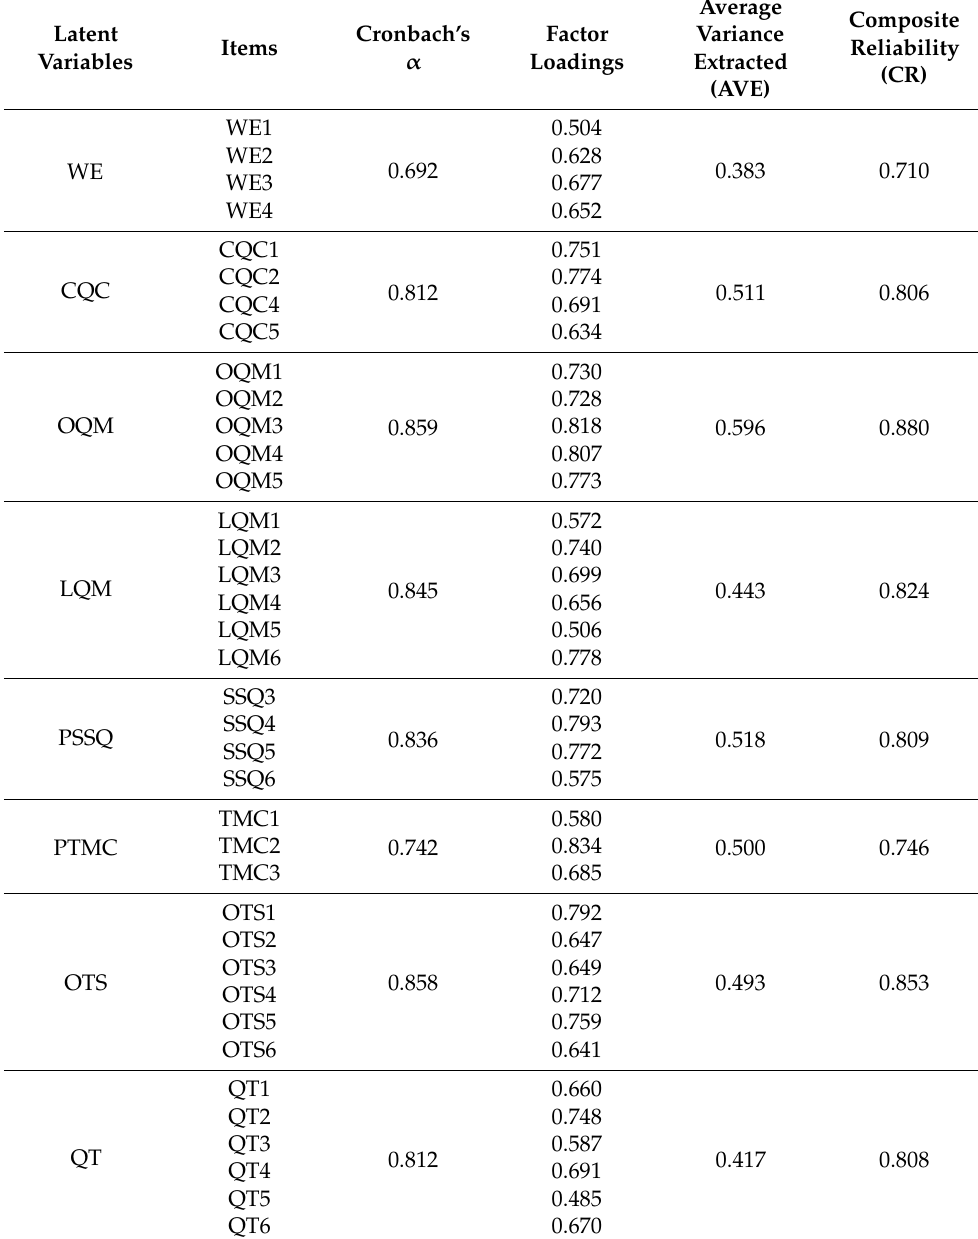
Table 6. Final SEM reliability and validity of the